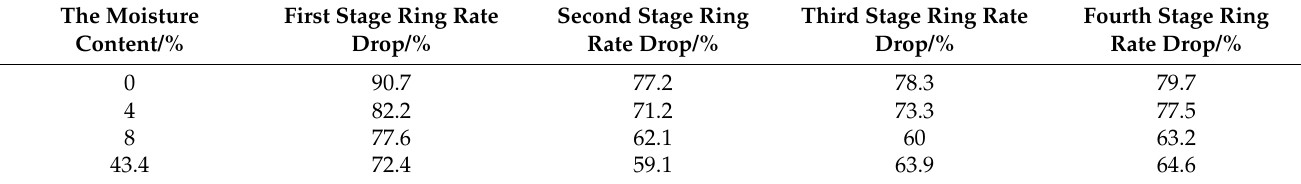
Figure 8. AE ringing count rate (red line) with increased axial strain (black line) for the four specimen groups. Table 3. Acoustic emission ringing rate decline in the four specimen